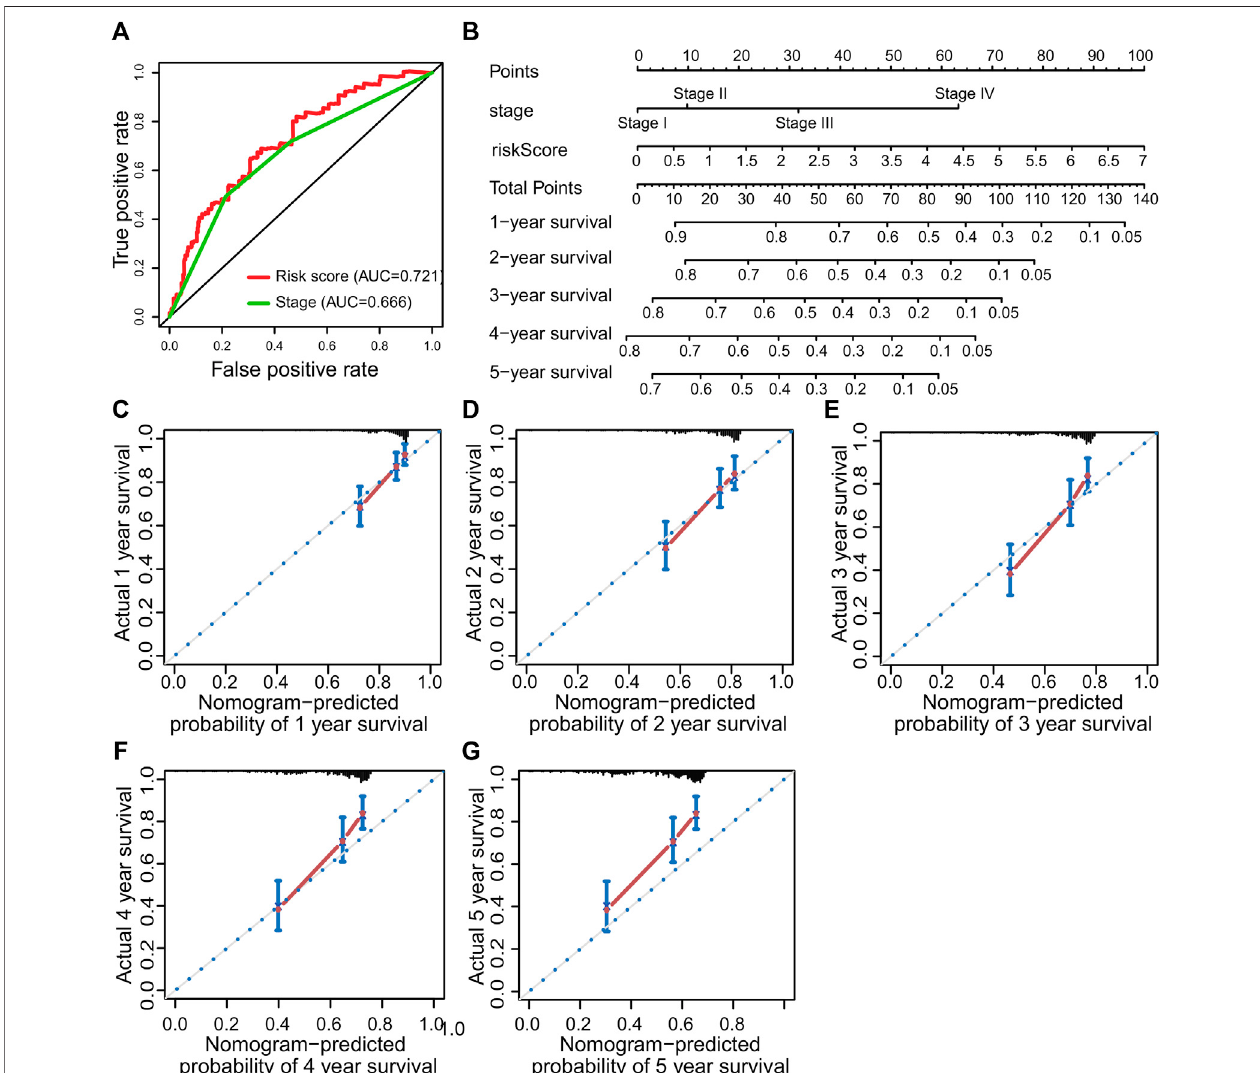
FIGURE6| Prognosticnomogramwasconstructedtopredicttheoverallsurvivalprobabilitybasedonthetrainingsetofpatientswithhepatocellularcarcinoma. (A) ROCcurveanalysis. (B) Thenomogramtopredict1-,2-,3-,4-and5-yearOSoverallsurvivalinthetrainset. (C – G) Thecalibrationplotsforpredictingpatient1-,2-,3-,4- and 5-year OS,